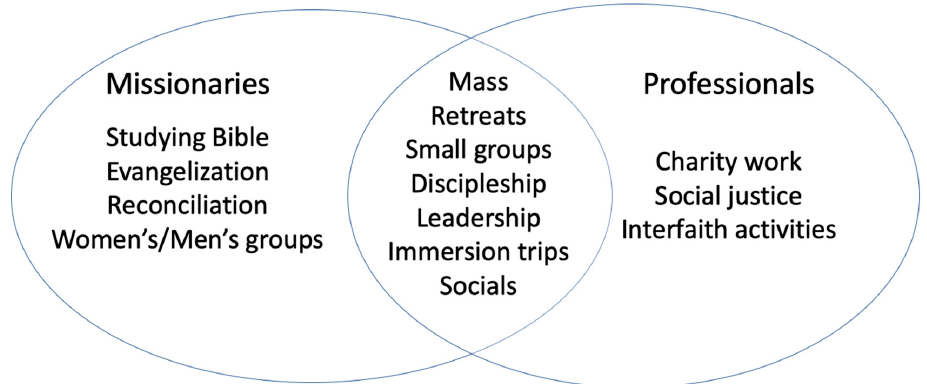
Figure 1. Ministerial activities that lead to students’ growth in the faith. United States Conference of Catholic Bishops, Washington, DC. Used with permission. All rights reserved.